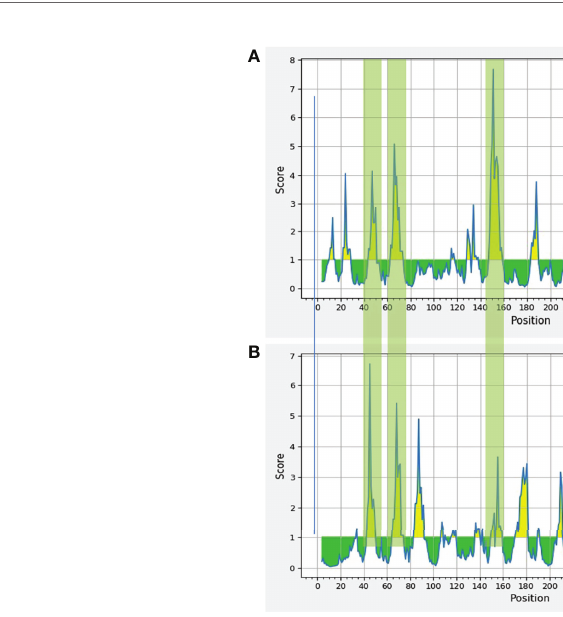
TABLE 2(B) | The epitope predicted by using the IEDB server and Bcpred server in P. vivax shown in the above table. IEDB server Bcpred server